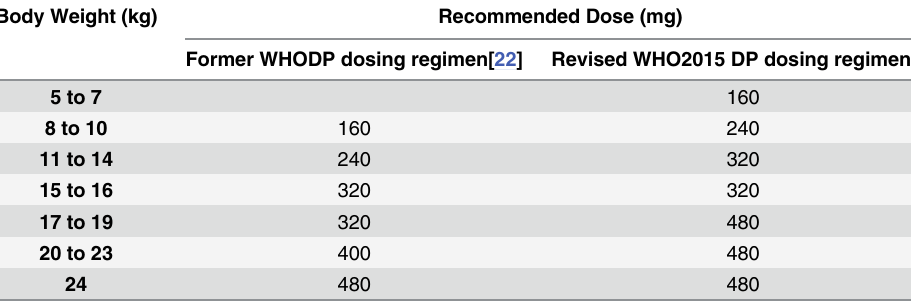
Table 1. DP weight-based dosing